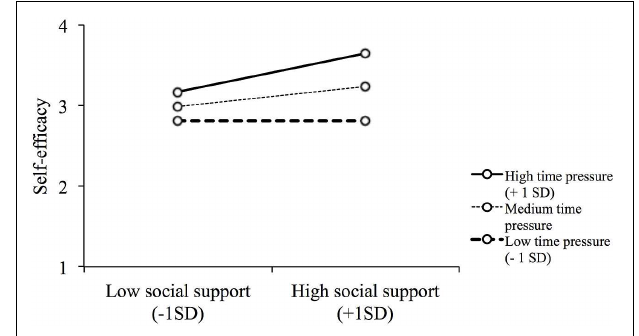
FIGURE 2 | The moderating effect of time pressure on the relation between social support from coworkers and self-efficacy.